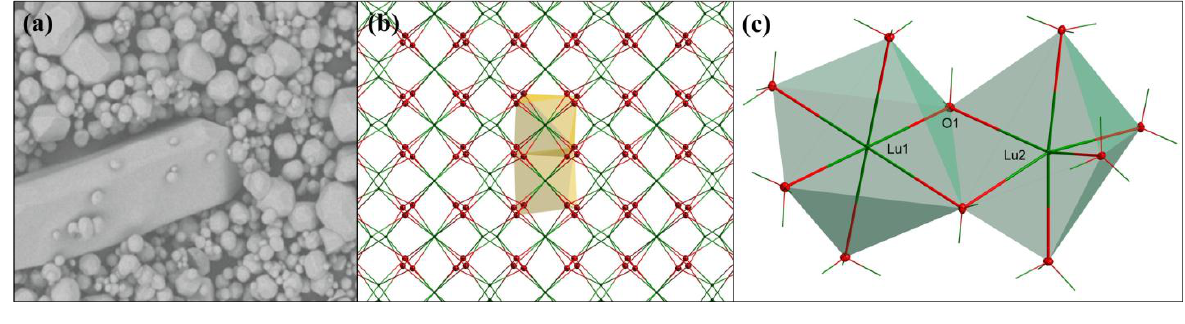
Table 2. Geometric parameters (Å,